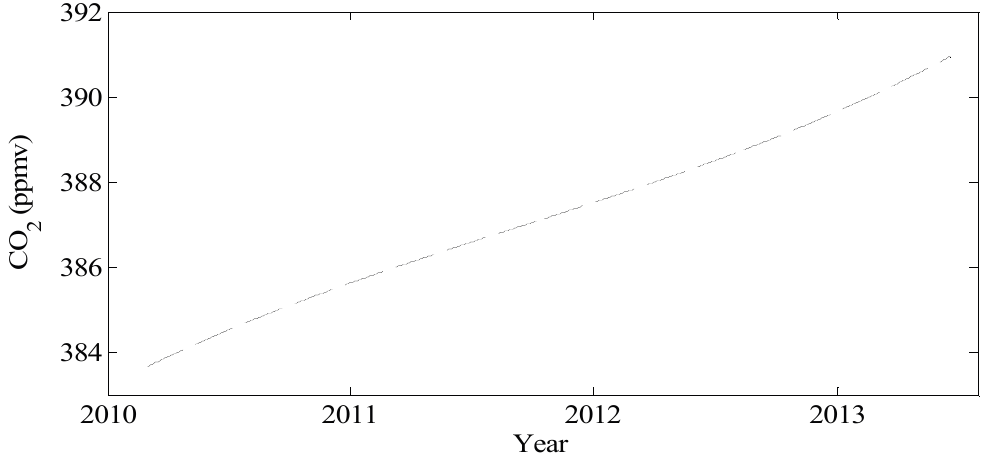
Figure 9. Long-term trend (dotted line) of the CO (2010 through 2013).